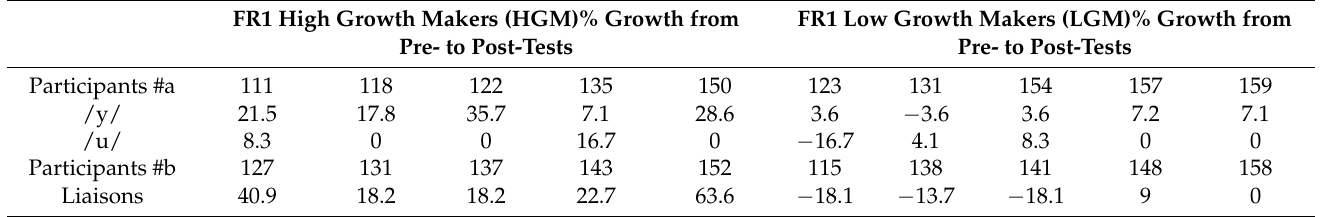
Table 6. Participants’ pronunciation growth from pre–post-tests in FR1.